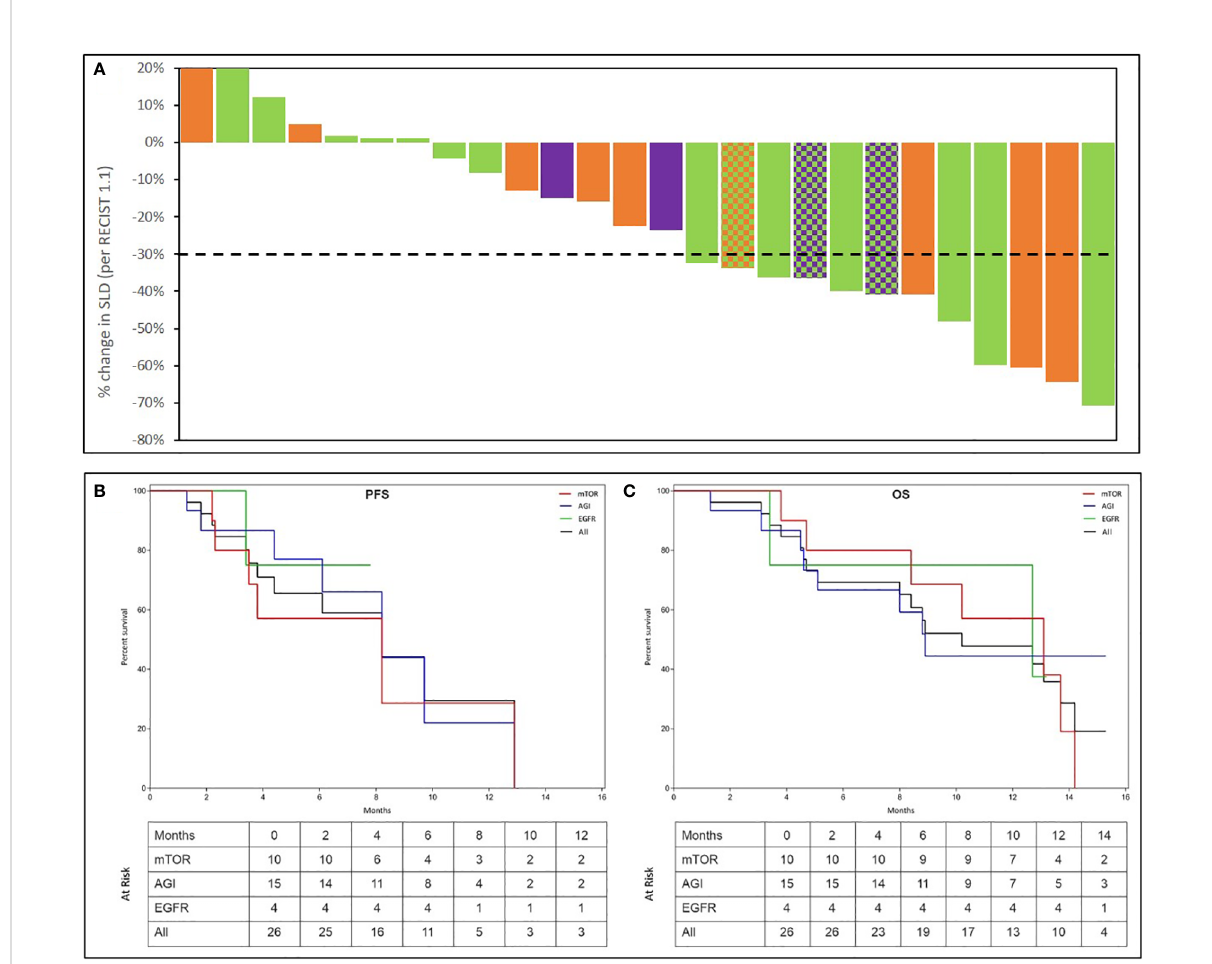
FIGURE 4 Summary of Outcomes. Treatment Response was evaluated as per RECIST 1.1. Percent change in dimensions of target lesions (Sum of Largest Diameters, SLD) between baseline and at best response are represented in the top panel (A) . Each bar represents the response in a unique patient. Patients are arranged in descending order of change (%) in SLD. Bars are colour coded as per the molecular indication: Orange: mTOR; Green: Angiogenesis; Purple: EGFR. In 3 patients, 2 signalling pathways were detected which are represented by a pattern of 2-colours, each corresponding to the respective pathway. The Kaplan Meier plots in the bottom panel show the Progression Free Survival (PFS (B) ) and Overall Survical (OS (C) ) in all patients as well as in sub-cohorts where activation of EGFR, Angiogenesis (AGI) or mTOR signalling was observed. Patients at risk at each milestone are indicated in the inset